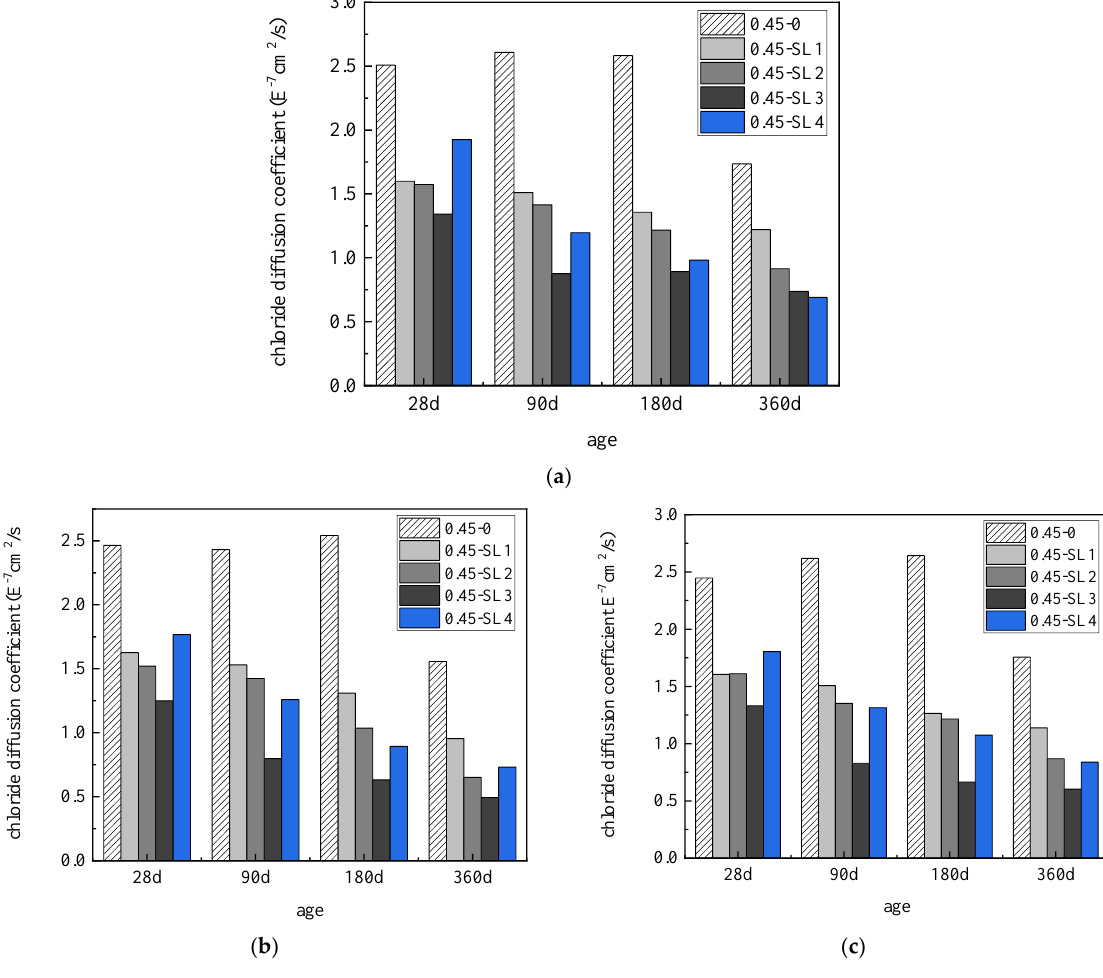
Figure 7. Chloride diffusion coefficients of concrete mixed with slag powder in different erosion environments: ( a ) sulfate, ( b ) chloride and ( c ) compound salt.